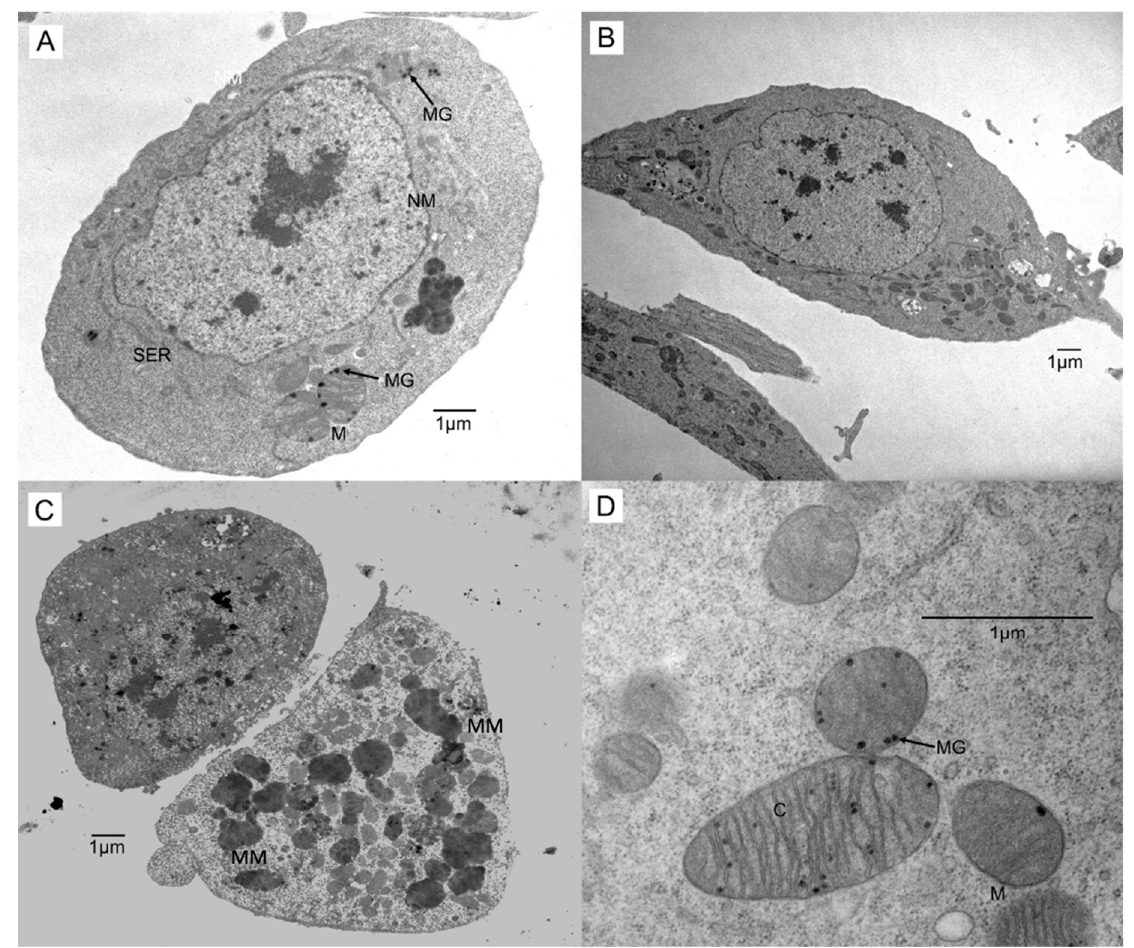
Figure 2. Electron micrographs illustrating the ultrastructure of treated cells. ( A ) A 20-HE treated cell with no morphological differentiation. The cell structure shows circular mitochondria (M) with densely stained mitochondrial granules (MG), smooth endoplasmic reticulum (SER), and a fully intact nuclear membrane (NM). ( B ) A 20-HE treated elongated cell showing morphology similar to Figure 3B. ( C ) Mitochondrial malformations (MM) in a cell treated with 20-HE and VTD. ( D ) Mitochondria (M) from a cell treated with 20-HE having numerous densely stained granules (MG) within the mitochondria and cristae ( C ).